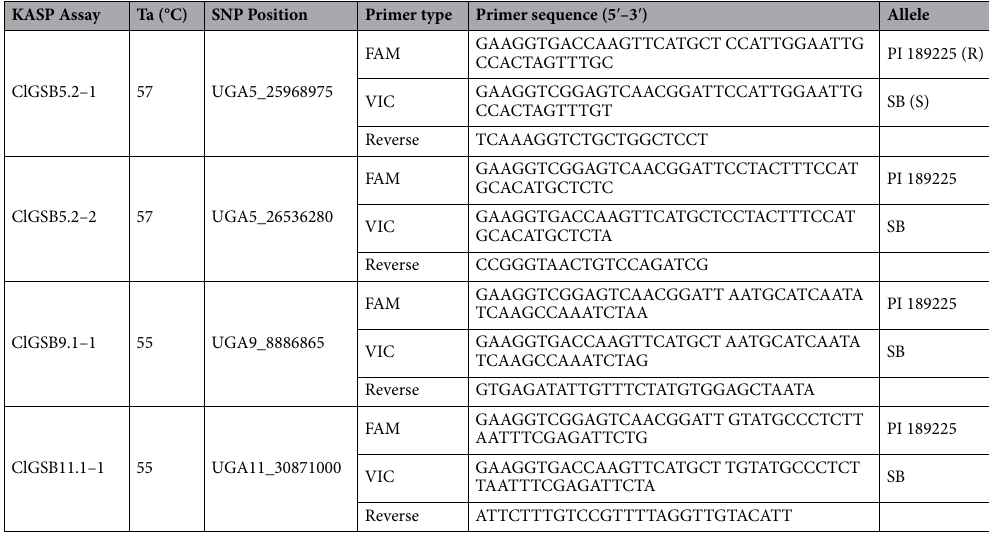
Table 3. KASP assays for flanking SNPs for GSB resistance QTL on chromosome 5 ( Qgsb5.2